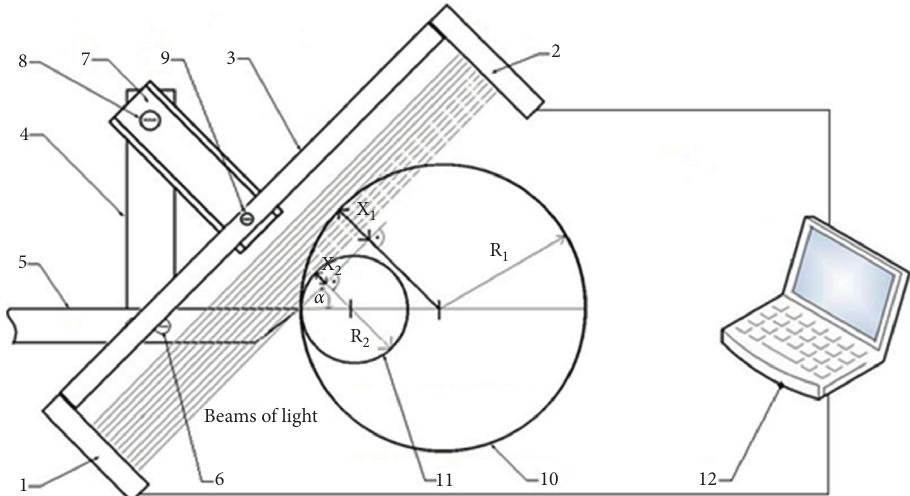
Figure 1: Optical sensor placed on tool holder. Description: transmitter of infrared light (1), receiver of infrared light (2), adjustable holder (3), console (4), turning tool (5), mounting bolt (6), adjustable arm (7), bolt of distance setting (8), bolt of angle setting (9), workpiece with radius R 1 (10), workpiece with radius R 2 (11), measuring, evaluation, and display device